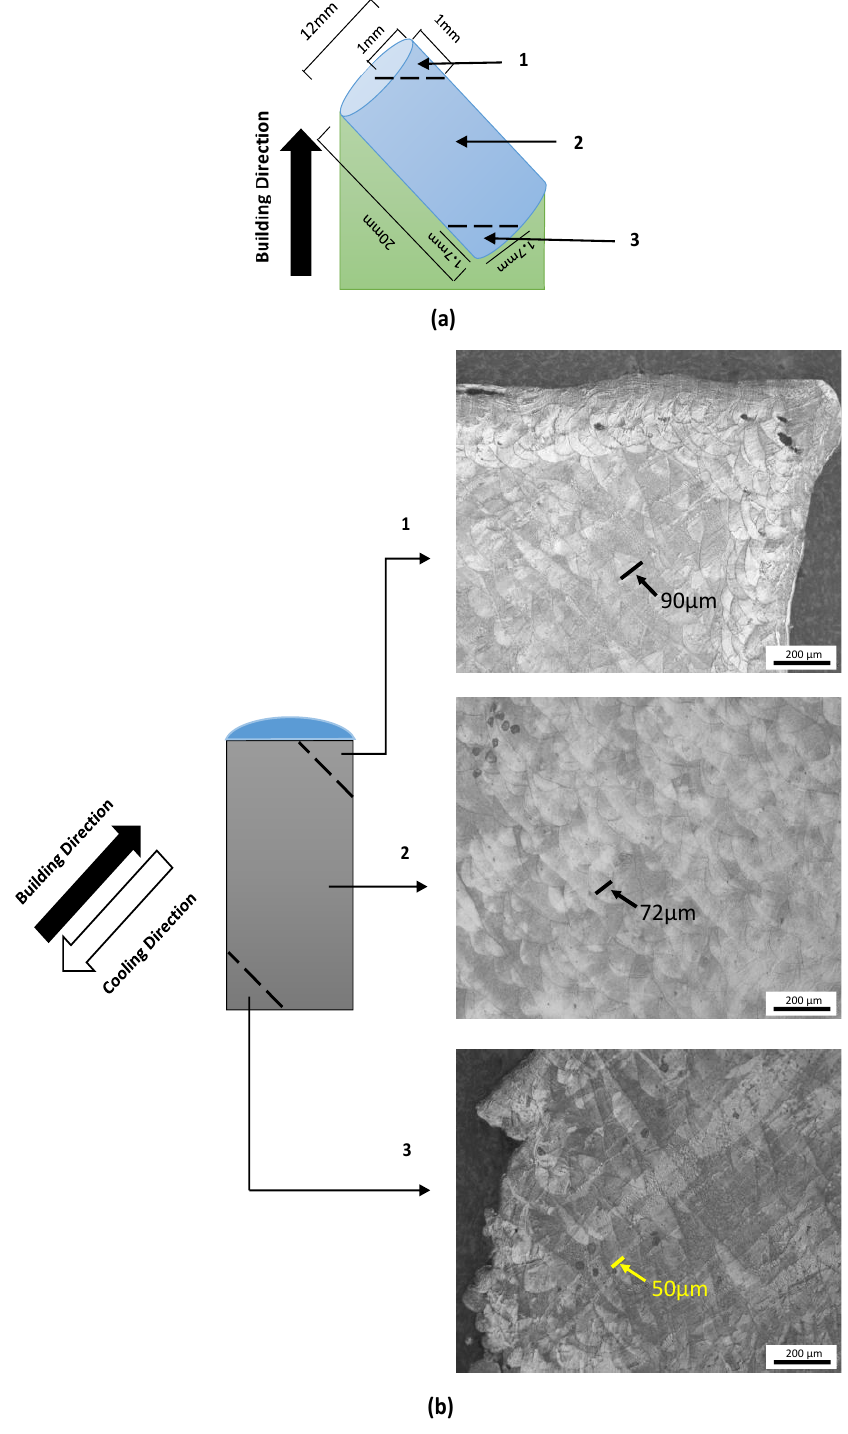
Figure 3. ( a ) Illustration of the 45° printed cylinder displaying three locations separated by dotted lines. ( b ) Melt pool morphology in locations 1, 2, and 3 taken from the vertical cross-section of the cylinder.